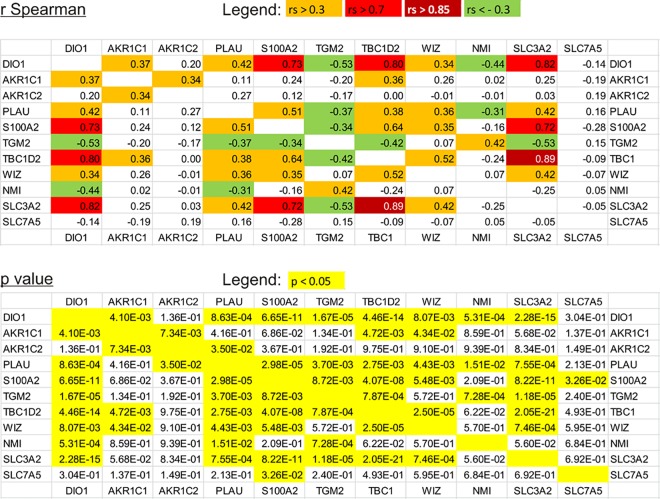
Matrix of correlations between the transcript expression of DIO1 and DIO1-affected genes in renal tumors.The upper table shows Spearman's rank correlation coefficient values for gene expressions analyzed in 30 RCC tumors and 30 paired-matched controls. Dark red: rs≥0.85, red: 0.85>rs≥0.7, orange: 0.7>rs≥0.3, green rs<-0.3. The lower table shows p values (yellow: p<0.05).